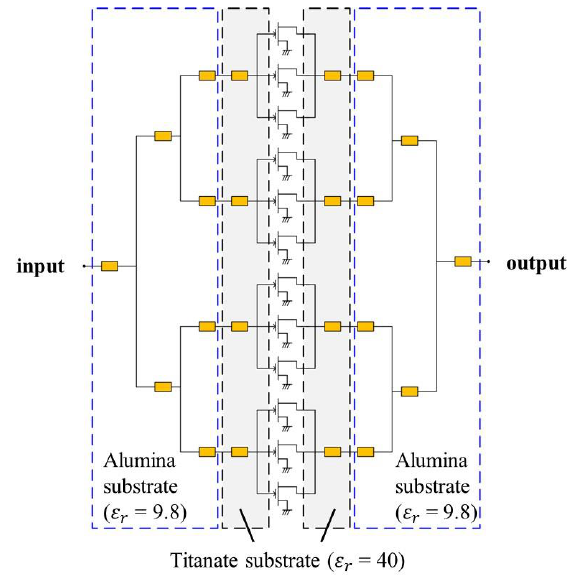
Figure 3. Schematic circuit diagram of the Ku-band 50 W GaN HEMT internally-matched power amplifier.